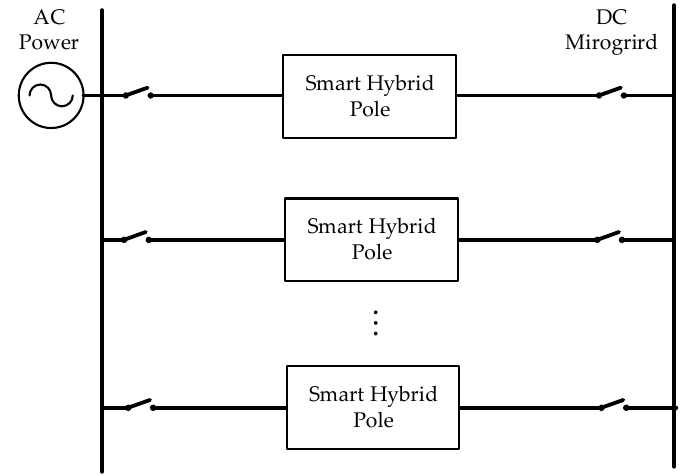
Figure 4. The integrated hybrid poles group by DC micro-grid.